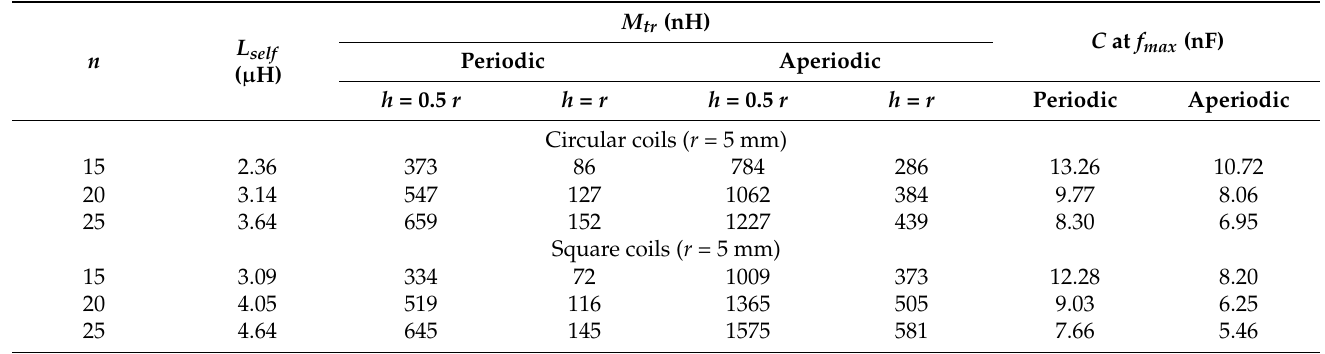
Table 3. The values of the compensating capacity at f max = 1 MHz, self, and mutual inductance for small circular and square coils ( r = 5 mm).